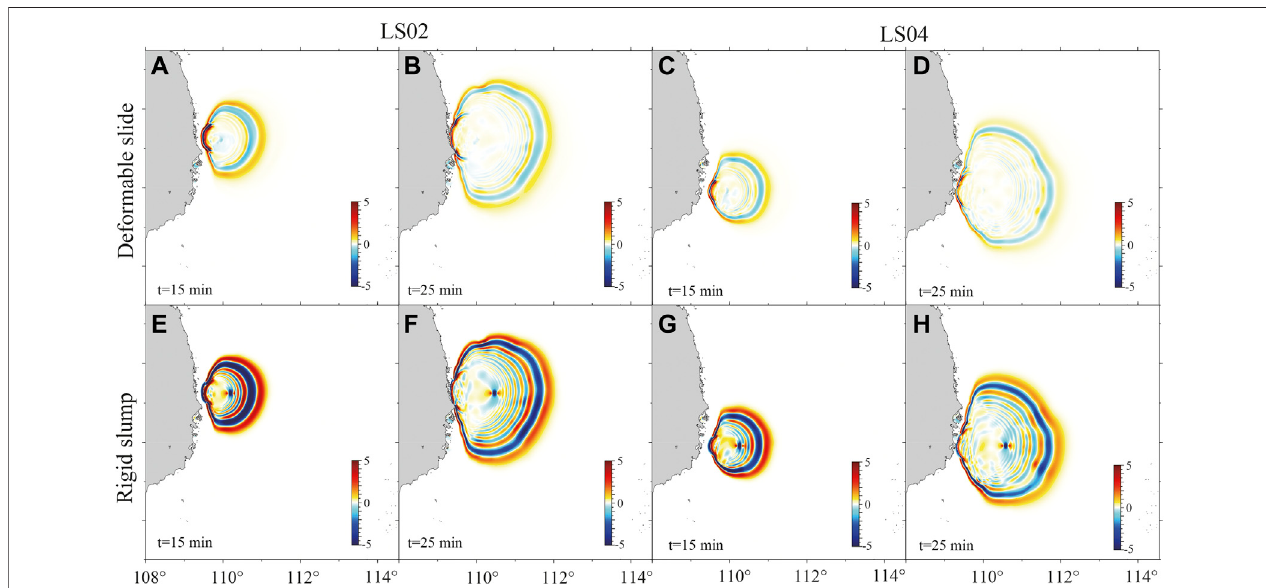
FIGURE 5 | Snapshots of tsunami surface elevation simulated by NWAVE at t = 15, 25 min after initiation. (A – D) : Deformable slide; (E – H) Rigid slump; (A,B,E,F) : LS02; (C,D,G,H) : LS04.